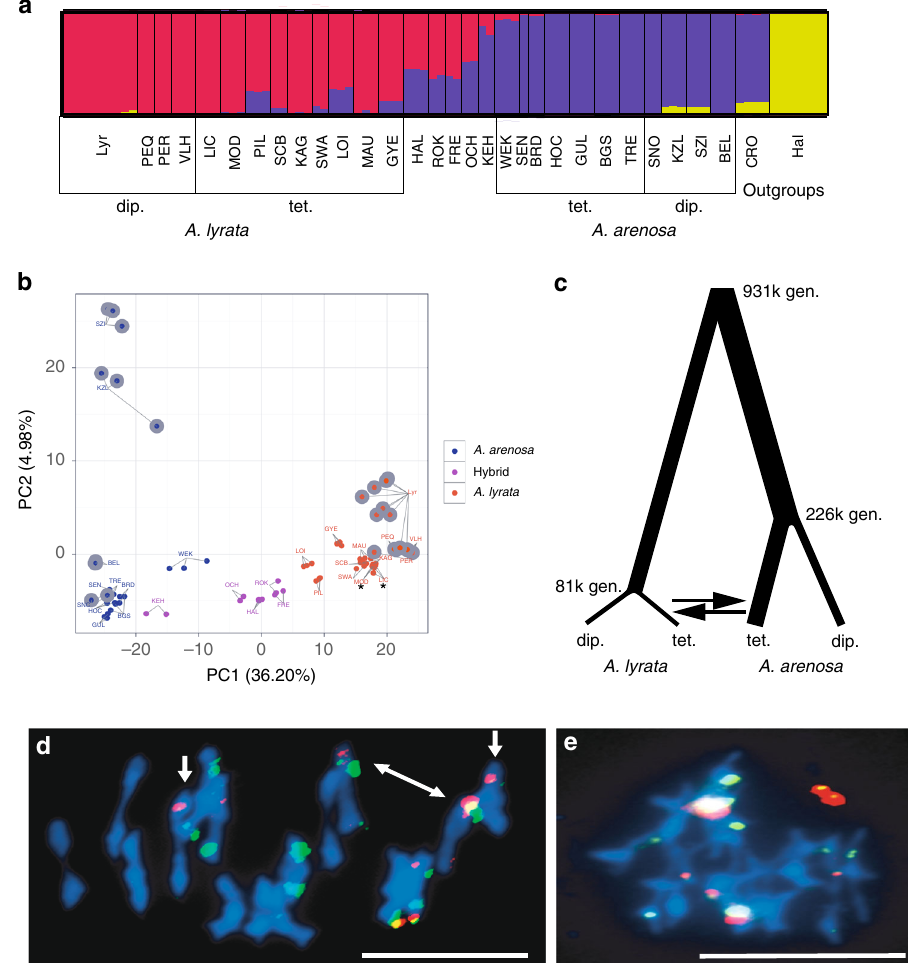
Fig. 1 Ploidy-speci fi c admixture and stable autotetraploid meiosis in A. lyrata . a A continuous range of admixture speci fi cally in tetraploid populations demonstrated with STRUCTURE analysis of nuclear SNP data (32,256 LD-pruned, 4-fold degenerate SNPs). Populations (in three-letter code) and population groupings (ploidy, species) are displayed. Populations are described in (Supplementary Table 1). b PCA shows individuals group on the main (PC1) axis by species and not by ploidy, with hybrid individuals located between A. lyrata and A. arenosa samples. We refer to all non-pure populations from the hybrid zone in the eastern Austrian Forealps as hybrids (see Supplementary Fig. 1). Diploids are indicated by grey outline. Asterisks (*) are placed under the Let tetraploid grouping; all other A. lyrata tetraploids (except the geographically divergent Pannonian GYE) are in the Lwt group. c Demographic parameter estimates for A. lyrata and A. arenosa populations. Line widths are proportional to estimates given in Supplementary Fig. 2. d , e Metaphase I chromosome spreads of nuclei from two ROK plants hybridised with 5S rDNA (red) and 45S rDNA (green). d MI scored as stable as 16 individual bivalents are observed, even though there are bivalents with unequal probes (white arrows), suggesting non-homologous rearrangements. e MI scored as unstable as the majority of chromosomes are connected to each other. Chromosomes are stained with DAPI; bar = 10 µ m. The source data underlying Fig. 1d, e are provided as a Source Data fi